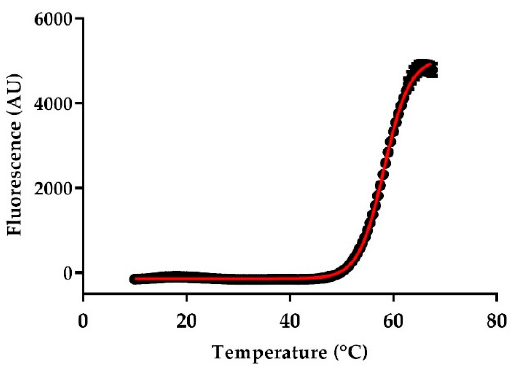
Figure 5. An example of Tm measurement of anti-CD33 Nb_12, as determined by ThermoFluor ® assay. The samples were heated from 10 to 95 ◦ C, with stepwise increments of 0.5 ◦ C per 30 s. AU stands for arbitrary units. The Tm for this Nb (58.00 ± 0.23 ◦ C) was determined by using Boltzmann’s Equation.